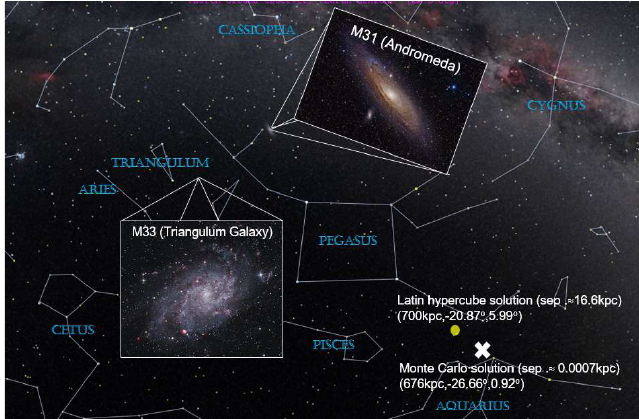
Figure 7. The local group’s CNO center plotted using The Aerospace Corporation’s SOAP version 14.0.7 as determined by independent implementations in C++ and FORTRAN.